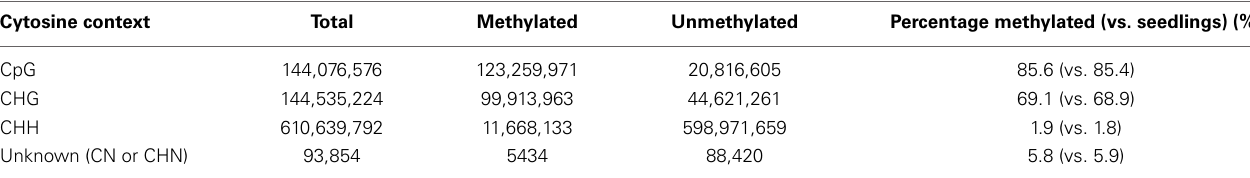
Table 4 | Detected DNA